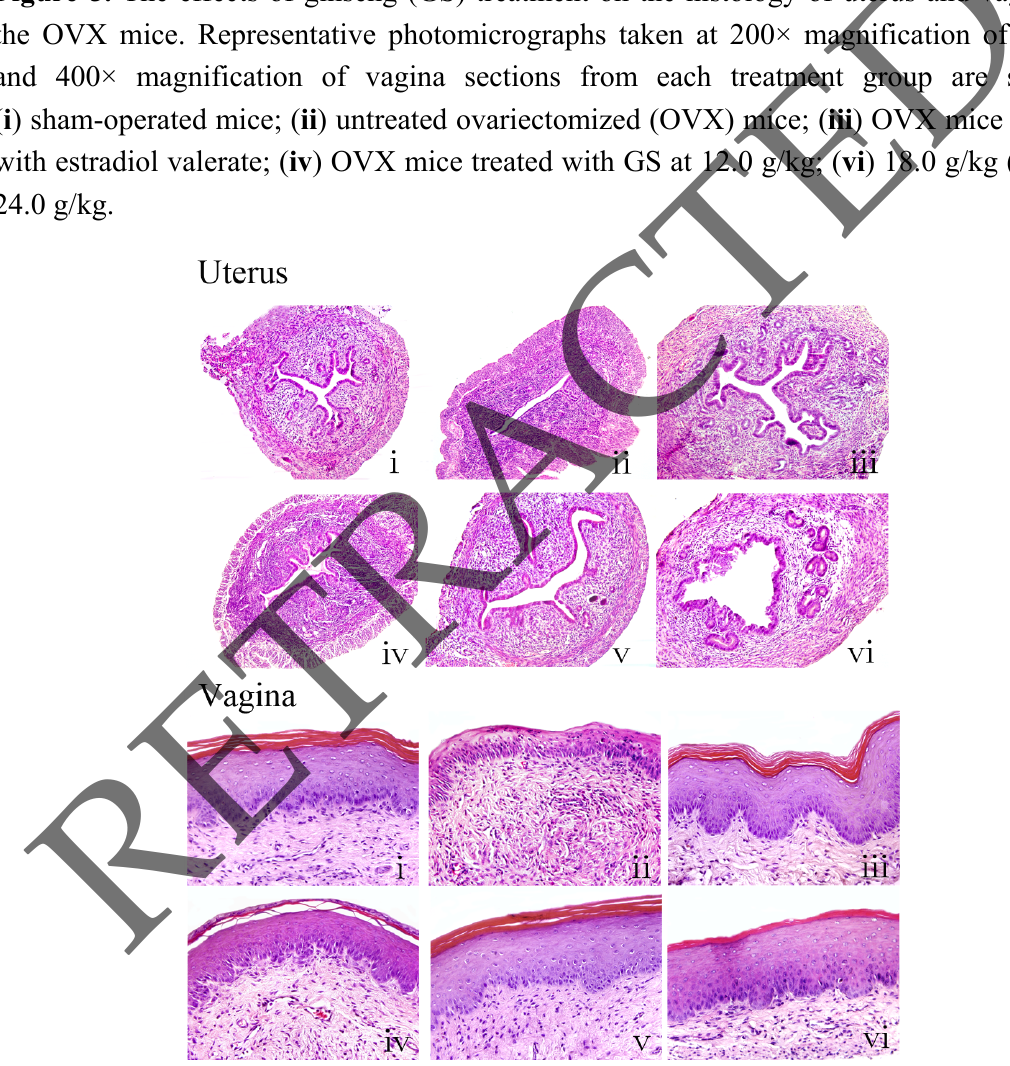
Figure 5. The effects of ginseng (GS) treatment on the histology of uterus and vagina in the OVX mice. Representative photomicrographs taken at 200× magnification of uterus and 400× magnification of vagina sections from each treatment group are